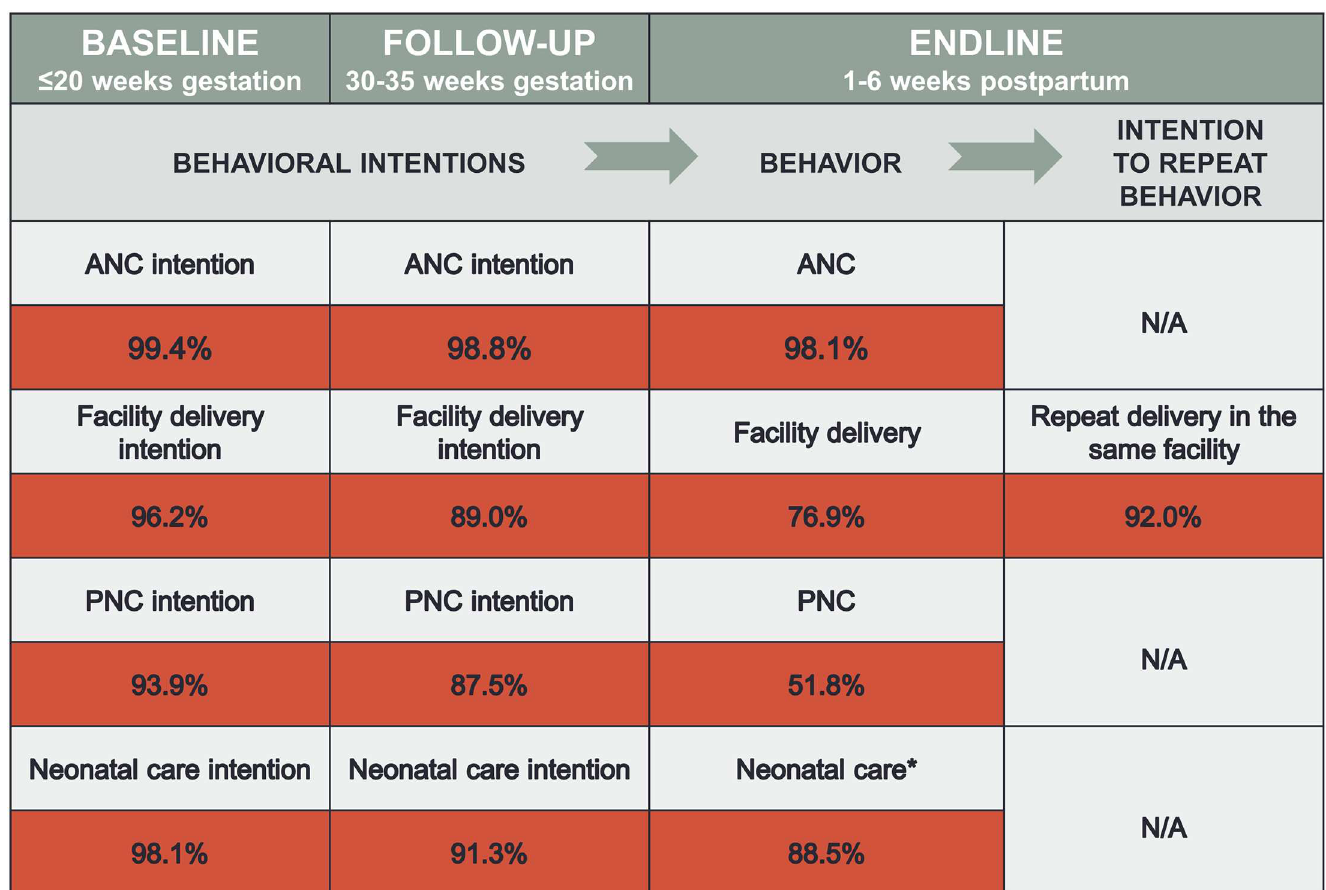
Fig 1. Intentions,behaviors and intentionsto repeatbehaviors regardinguse of maternaland neonatalhealthservices. Notes : ANC, antenatal care;PNC, postnatalcare; * of those with a live birth.